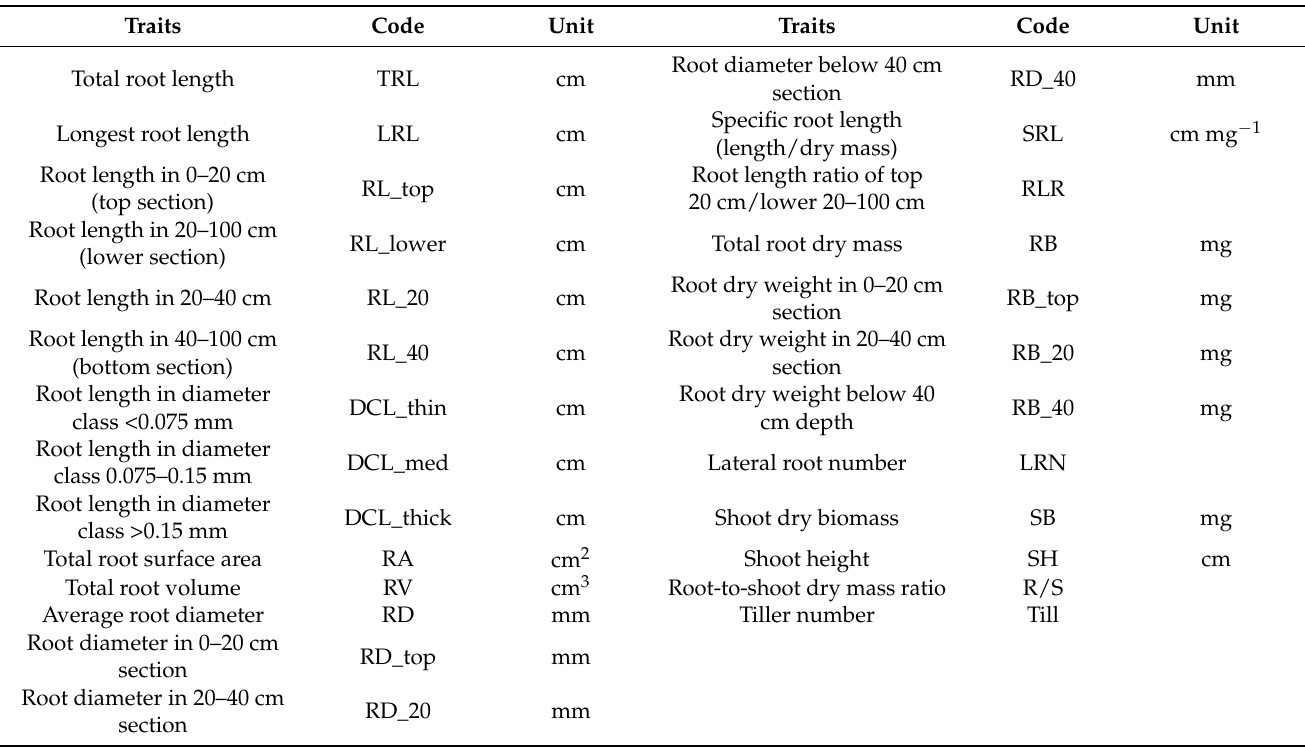
Table 1. Description of 23 root- and three shoot-related traits in 189 barley genotypes in the early growth stage assessed in the semi-hydroponic phenotyping system 30 days after transplanting in a temperature-controlled glasshouse. Traits Code Unit Traits Code Root diameter below 40